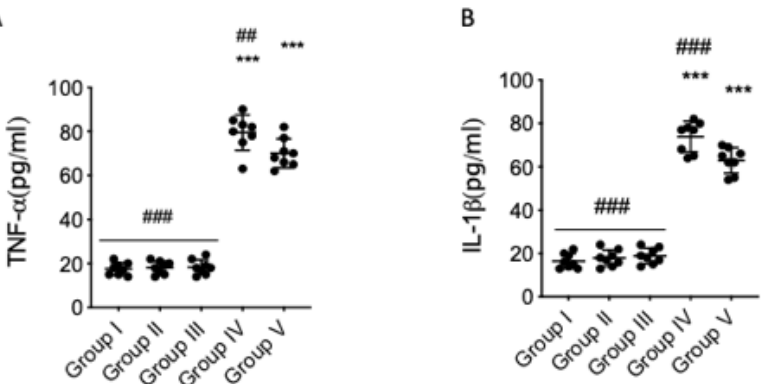
Figure 4. Effect of quercetin on serum cytokine in AFB1 mice. Group I (control); Group II (veh + control); Group III (quercetin-only); Group IV (AFB1); Group V (afb1 + quercetin). Serum tumor necrosis factor- α (TNF- α ) ( A ) and IL-1 β ( B ) proinflammatory cytokine levels were detected. Quercetin was able to reduce proinflammatory cytokines in AFB1 mice. The results are expressed as means ± SEM of 8 animals for each group. * p < 0.05 vs. veh control; # p < 0.05 vs. AFB1 + quercetin.